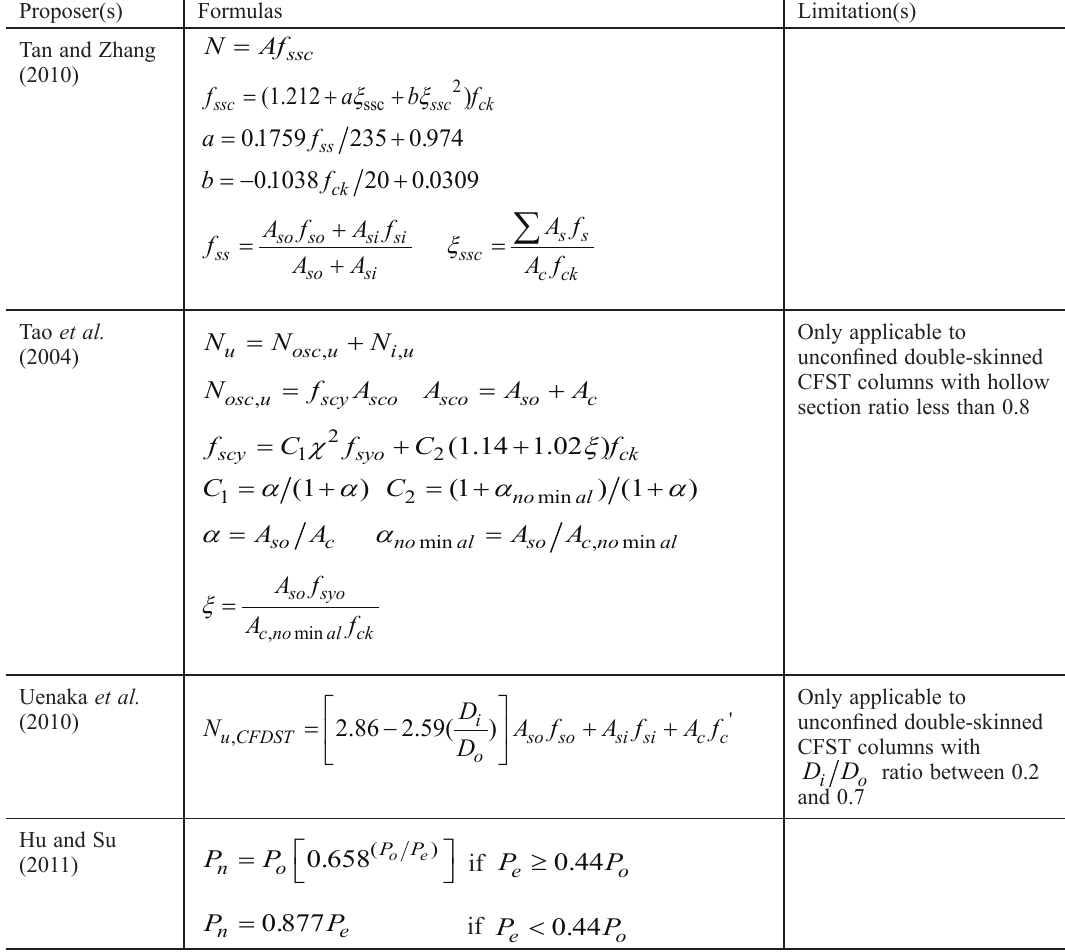
Only applicable to unconfined double-skinned CFST columns with hollow section ratio less than